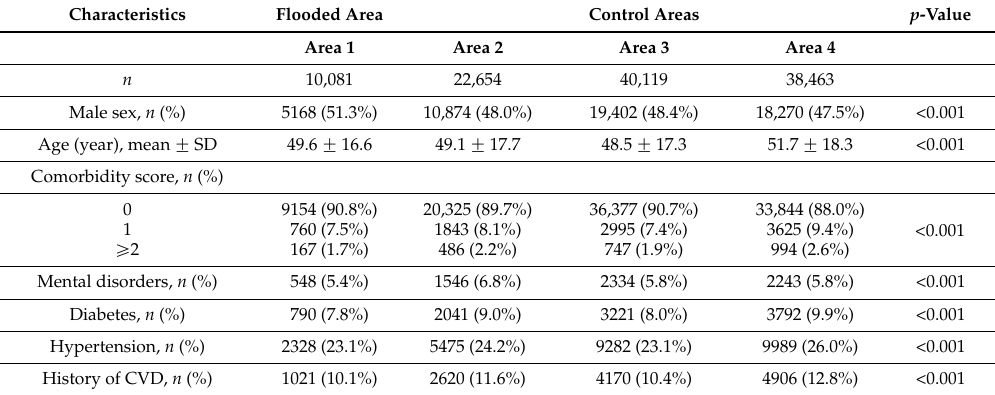
Table 1. Baseline characteristics of the flooded and the control populations in spring 2011.